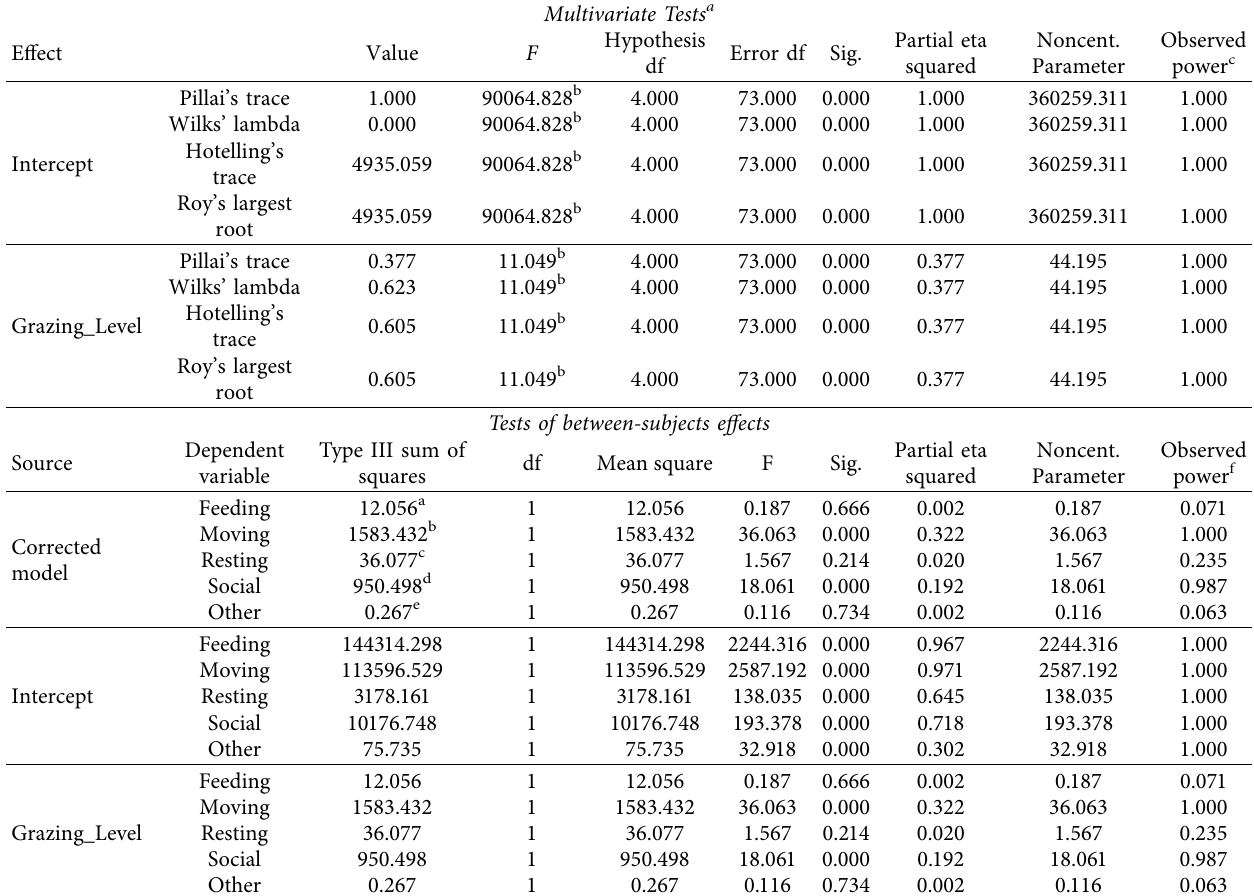
Figure 5: Comparison of activity time budget between the nongrazed and grazed areas. Table 1: Multivariate analysis result. Multivariate Tests